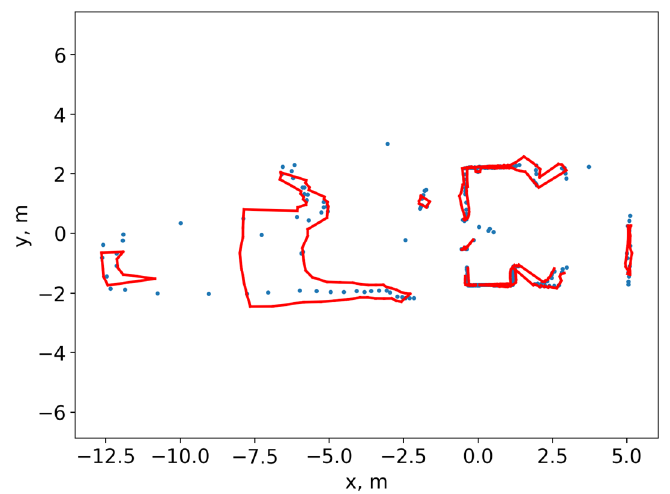
Figure 6. The result of the algorithm on actual data. The obstacle prediction is shown in red. The sensor points are shown in blue.